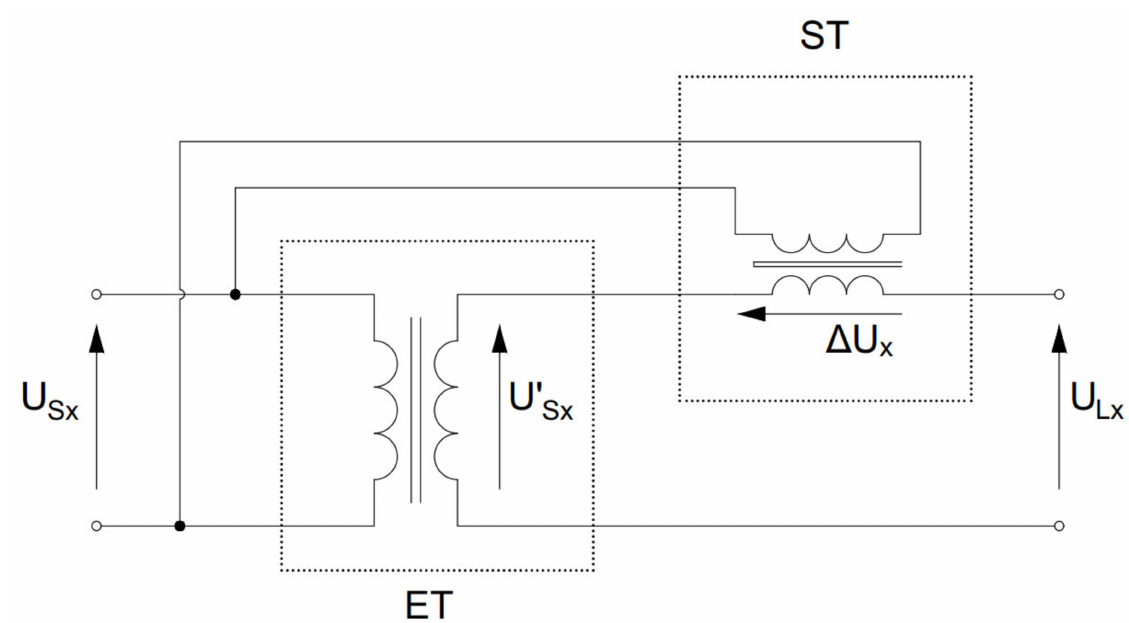
Figure 7. The ACPST single-phase equivalent scheme. ET—extra transformer responsible for longitudinal voltage regulation, ST—series transformer implementing quadrature voltage into the line, U Sx —input voltage of any phase, U’ Sx —regulated longitudinal voltage of any phase, ∆ Ux—quadrature voltage injected into the line, U Lx —PST output voltage of any